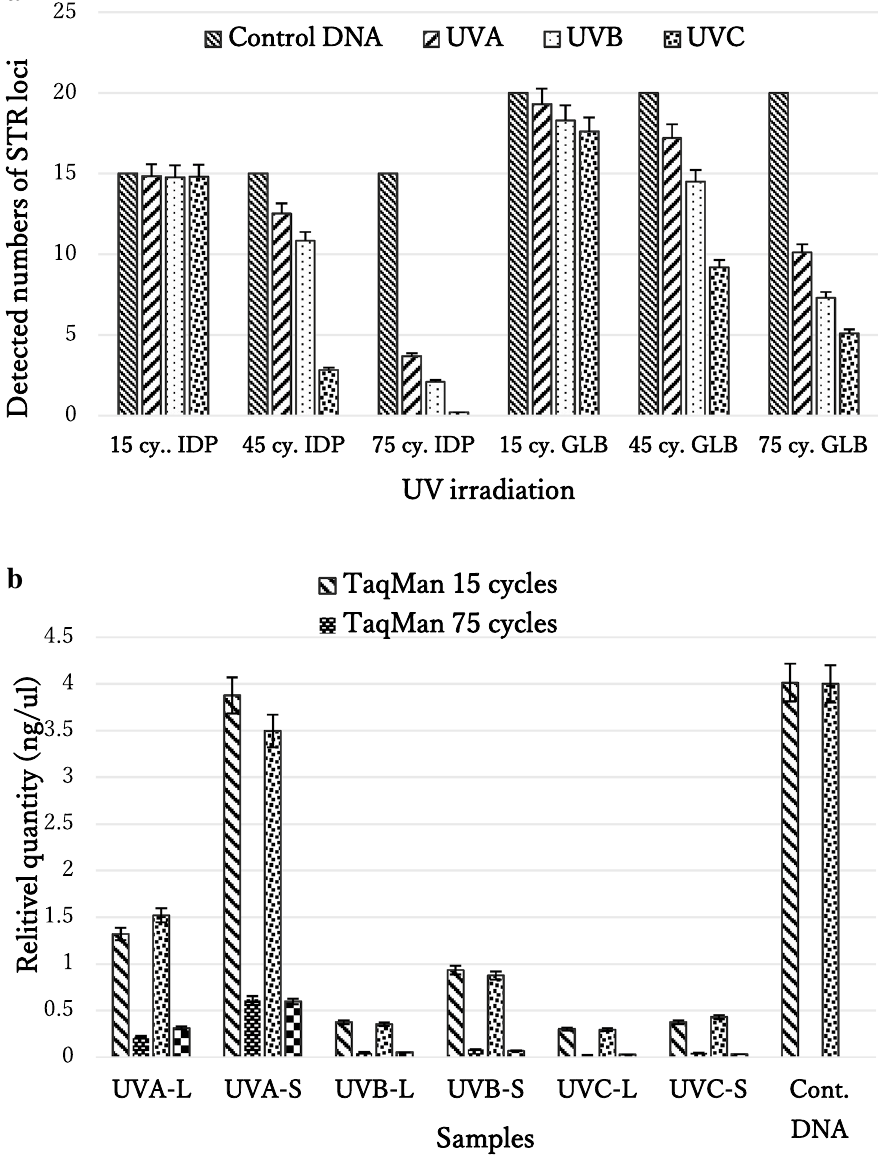
Figure 1. ( a ) Average number of detected STR loci ion human bloodstains using IDP and GLB methods following UV irradiation in each three cycles (15, 45 and 75). ( b ) Quantity of DNA in dried blood samples detected by long (-L) and short (-S) TaqMan assays as well as large autosomal (-L) and small autosomal (-S) Quantifiler Trio using real-time